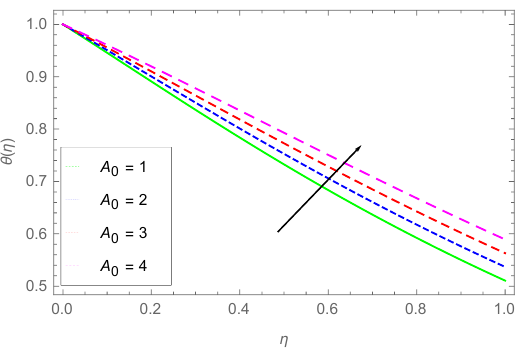
Figure 11. θ ( η ) dependence on A 0 . Figure 12 shows the variation of the temperature distribution with the enhancing Eckert number Ec . The values of Ec were taken as 1.0, 1.5, 2.0, 2.5. It is evident from the figure that the rising Ec values augment the fluid’s temperature. The rate of increase rises with the higher Ec values as evident from the wider separation between different curves. The different curves overlap at about 0.9. Thus, the enhancing fluid velocity associated with higher values of Ec results in an increase in the heat dissipation, which augments the fluid’s temperature